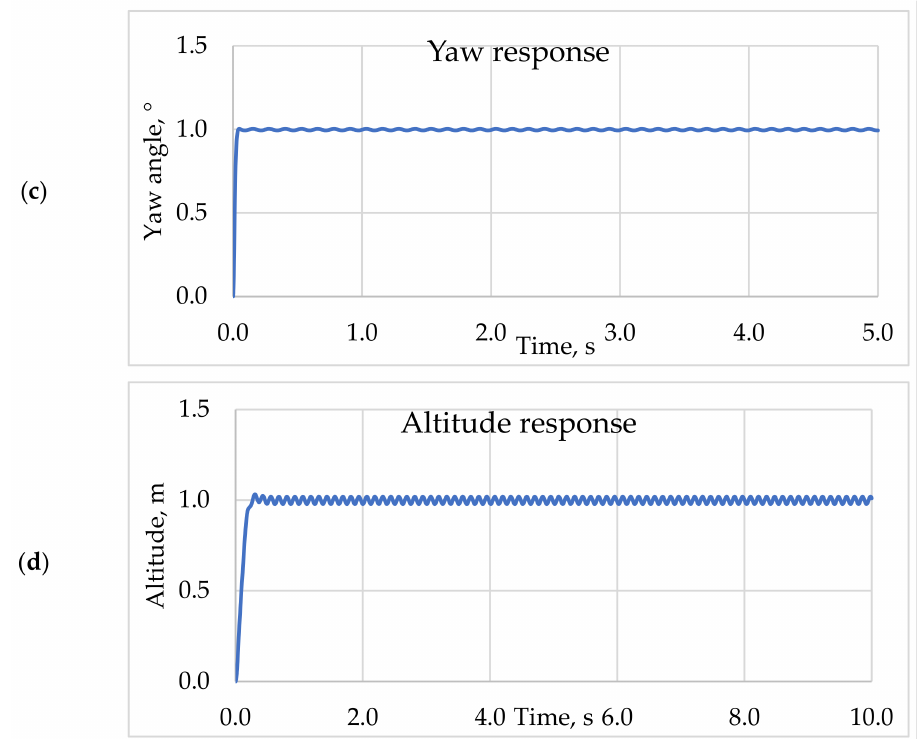
Figure 6. The step response of the system in the presence of unknown external disturbance, ( a ) roll, ( b ) pitch, ( c ) yaw, and ( d ) altitude